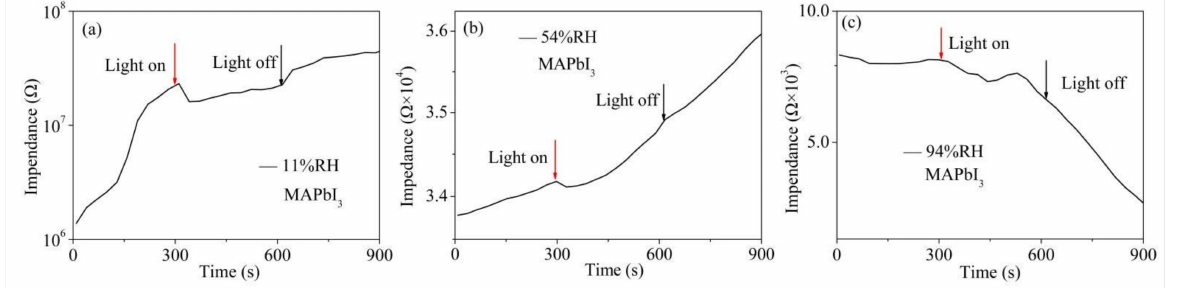
Figure 7. Repeatability ( a ) and long-term stability ( b ) of the MAPbI 3 -based sensor.